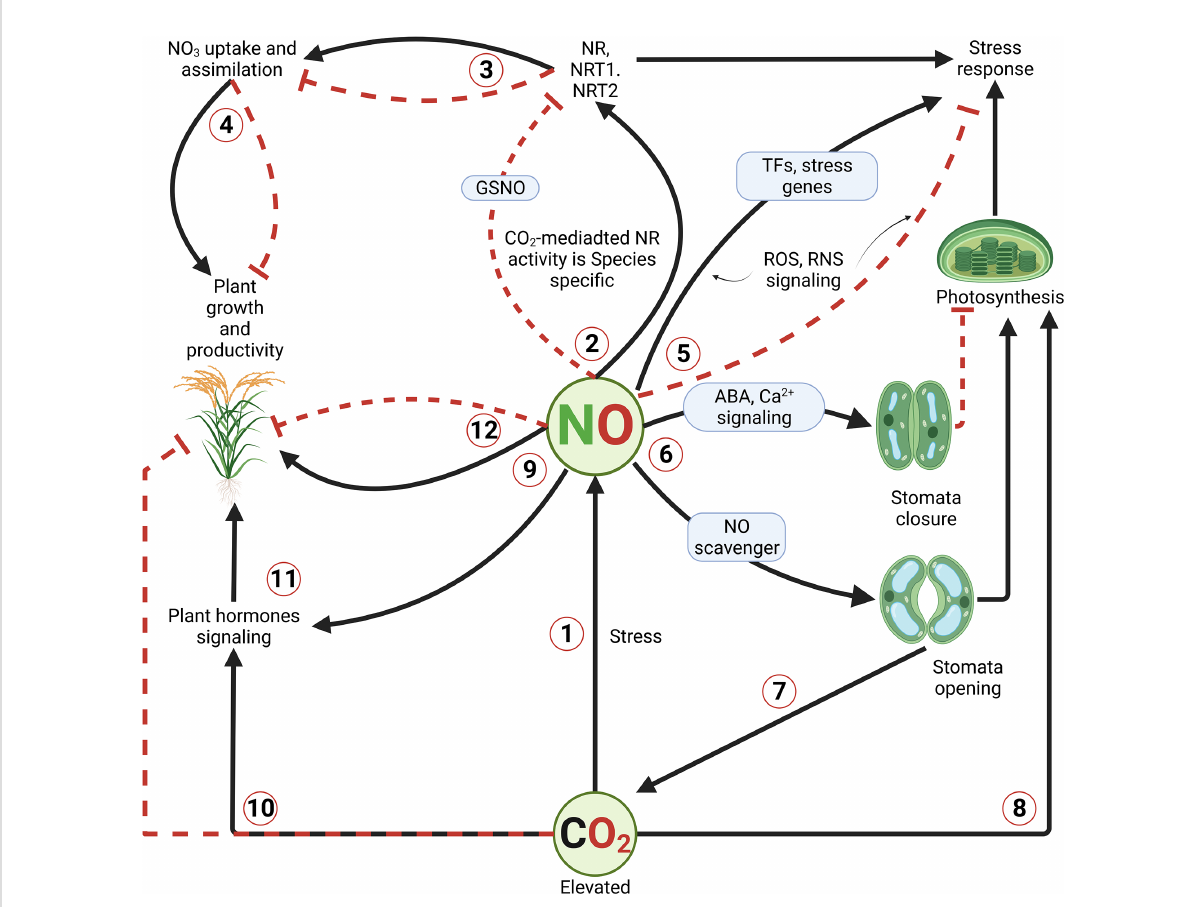
FIGURE 1 Illustration of elevated carbon dioxide (CO 2 )-mediated NO signaling in plants. Unlike other abiotic stresses, elevated CO 2 levels have been shown to have both bene fi cial and detrimental effects on plant growth and development. Bene fi cial effects are resumed in enhancing the photosynthetic capacity and promotion of growth and development. However, at a certain accumulation level, CO 2 induces various signaling cascades, in which NO is said to play a central role. In the process, nitrate reductase and transporter encoding genes are induced, along with the Ca 2+ and ABA signaling, ROS and/or RNS signaling, resulting in differential stomatal conductance, enhancement of NO 3 uptake and assimilation, and eventually better growth and productivity. Continuous black lines with an arrow indicate positive regulation or induction, while dash red lines with a perpendicular bar denote negative regulation or inhibition in case of over production/accumulation of